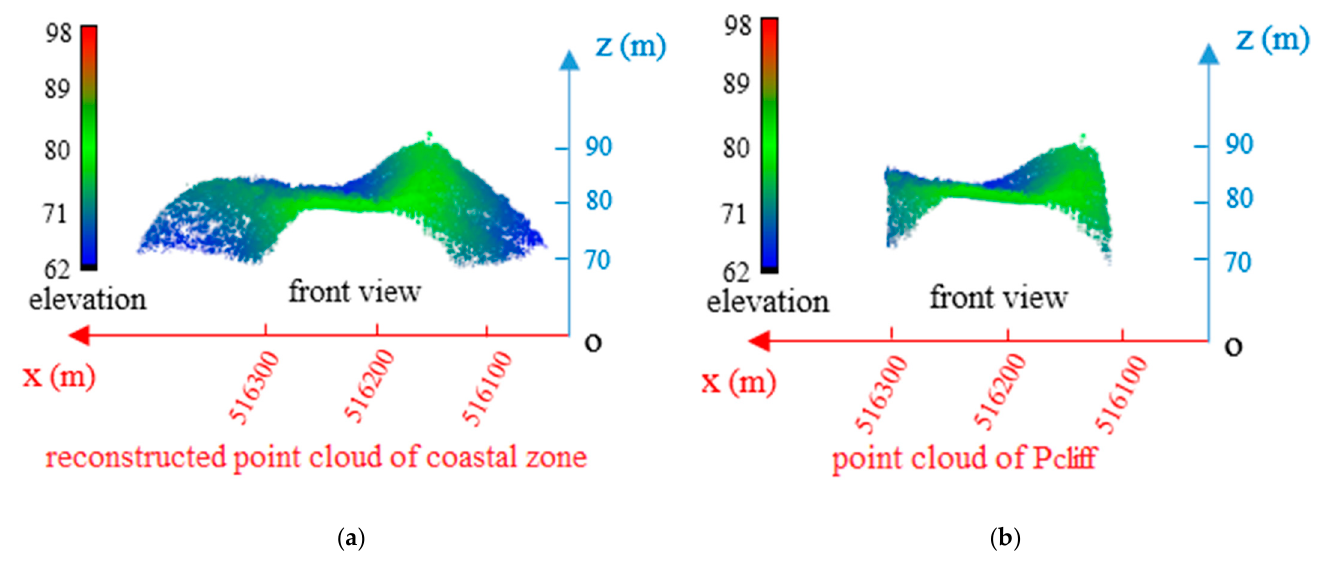
Figure 7. ( a ) Rough extraction of point cloud in cliff segment. ( b ) Extraction of point cloud in cliff segment in combination with the x coordinate interval of points A and